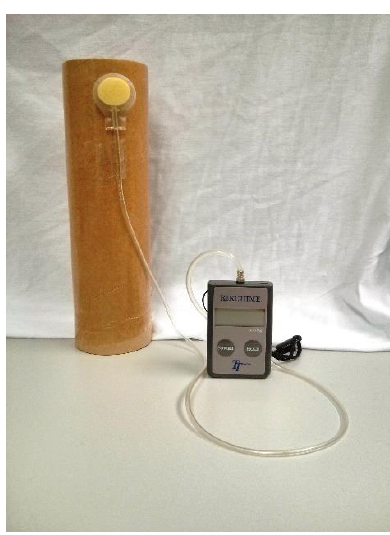
Figure 2. Set-up for interface pressure measurement. Table 1. Characteristics of the memory bandage.